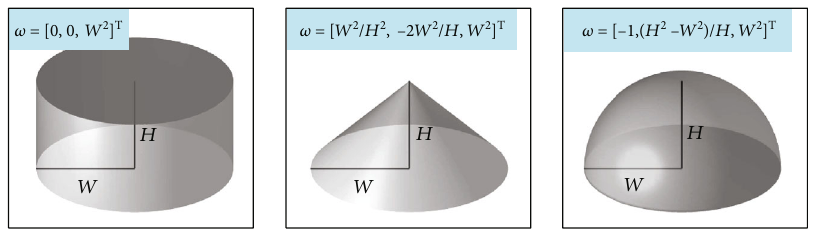
Figure 2: Three typical geometries of obstacle and their parameters.